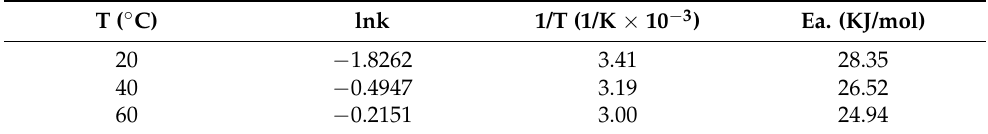
Table 4. Calculated values and